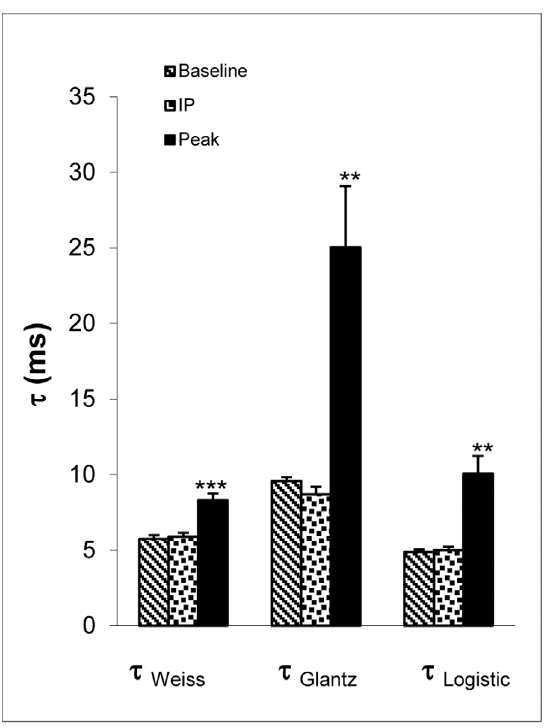
Figure 4. Tau at baseline, inflection point (IP), and at peak effect of phenylephrine. **: p , 0.01; ***: p , 0.001, self-paired t-test of black bar versus texture bar or dotted bar in the same category. IP: inflection point.